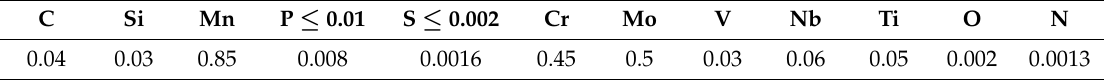
Table 1. Chemical composition of high-strength steel (wt